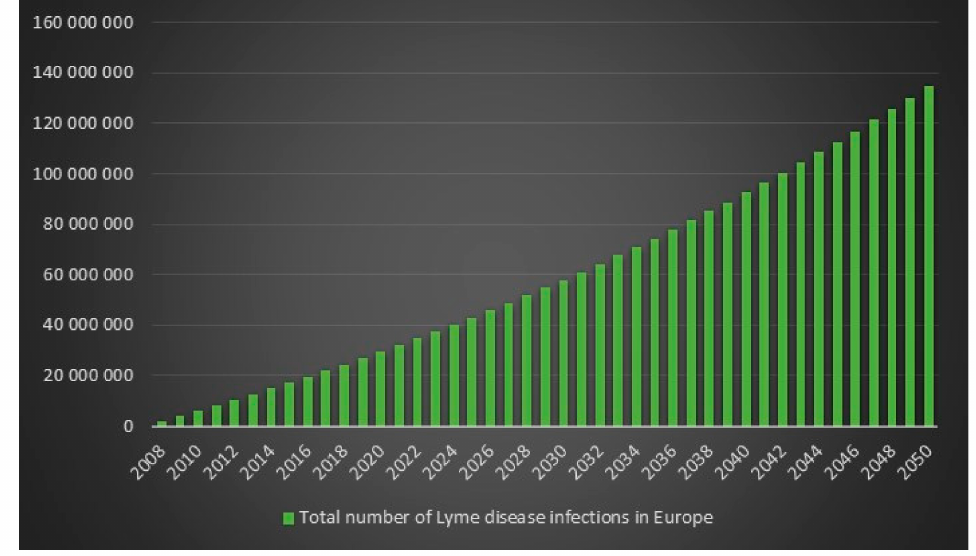
Figure 15. Total number of Lyme disease infections in Europe between the years 2008 to